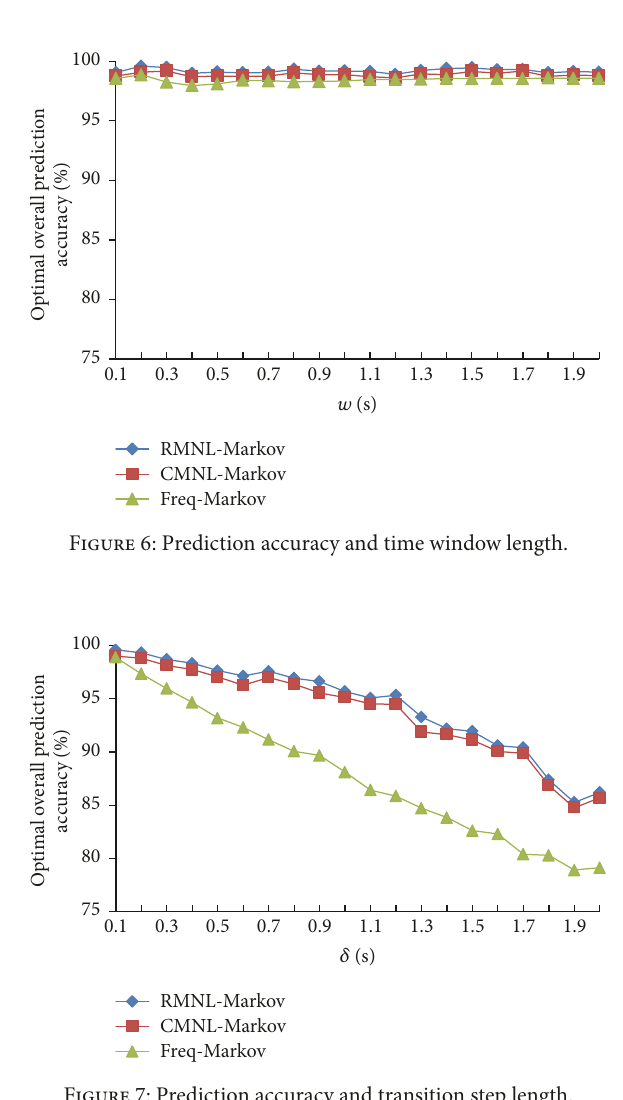
Figure 7: Prediction accuracy and transition step length.